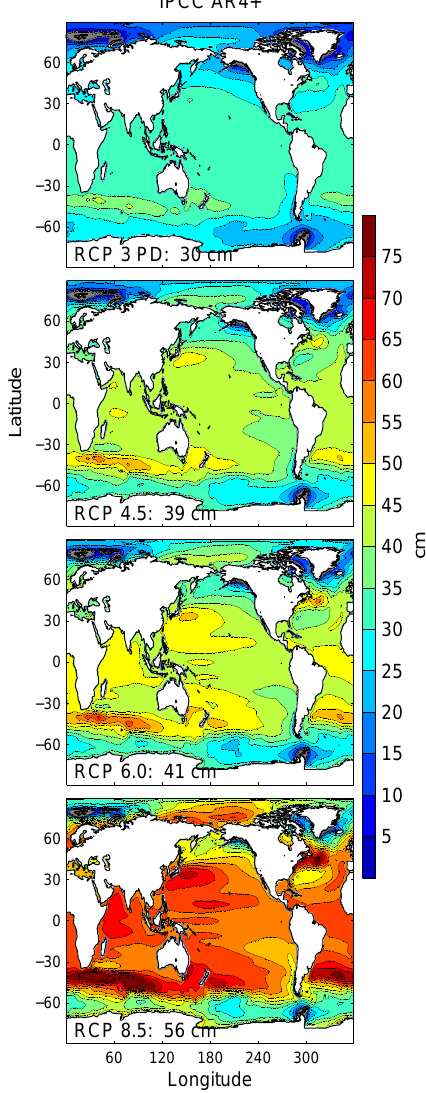
Fig. 7. Projected median regional sea level change for all RCP sce- narios (from RCP 3PD to RCP 8.5) in the IPCCAR4 + ice sheet case. Contour lines are every 5cm. Grey shading indicates areas of sea level